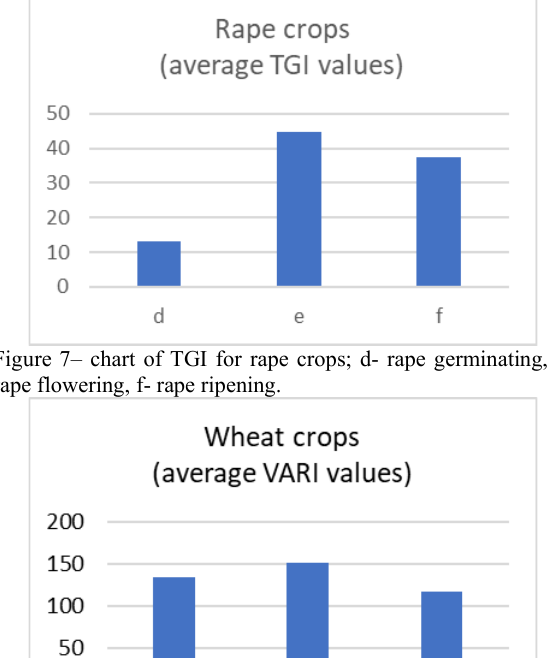
Figure 6 - chart of TGI for wheat crops; a- wheat germinating, b-wheat flowering, c-wheat ripening.